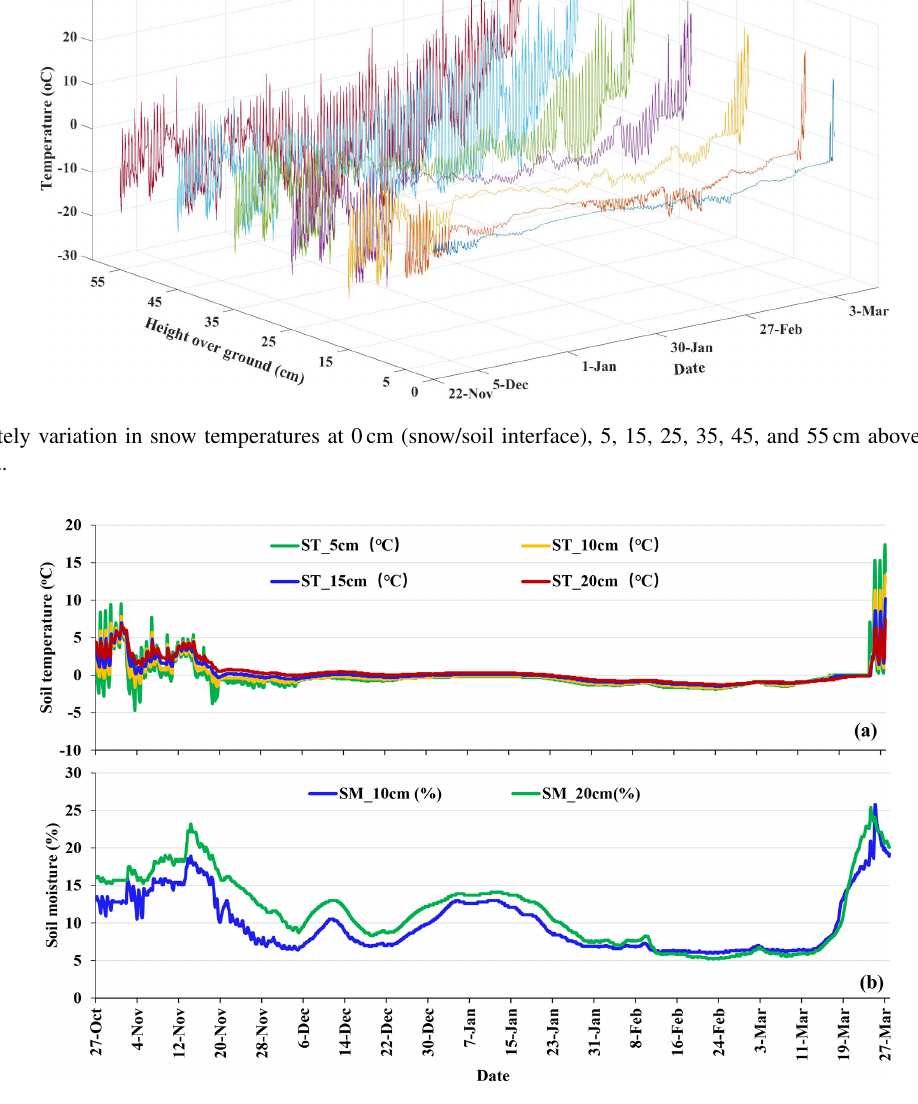
Figure 11. (a) Hourly soil temperature at 5, 10, 15, and 20cm below the snow/soil interface, and (b) soil moisture at 10 and 20cm below the snow/soil